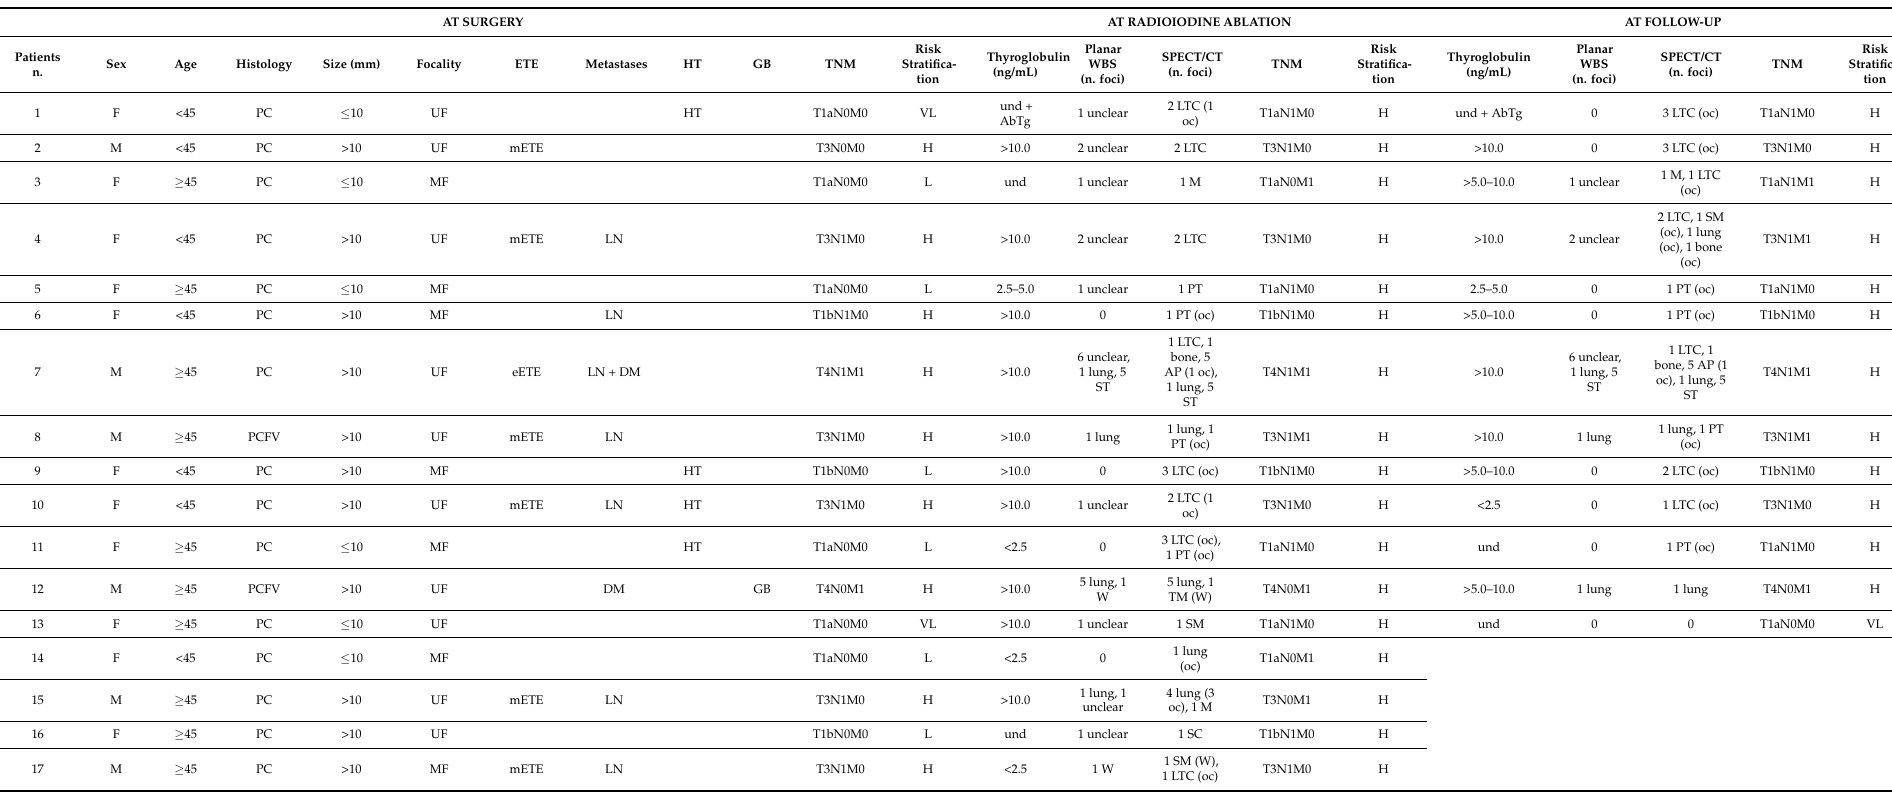
Table 3. A total number of metastases evidenced by SPECT/CT (n. 49) in 17/106 patients and by WBS (n. 32) in 13/17 patients at radioiodine ablation; 13/17 cases (cases 1–13) also monitored during follow-up, underwent progression (cases 1–4), stabilization (cases 5–8) and improvement (cases 9–13) of the disease. ATSURGERY ATRADIOIODINEABLATION Patients